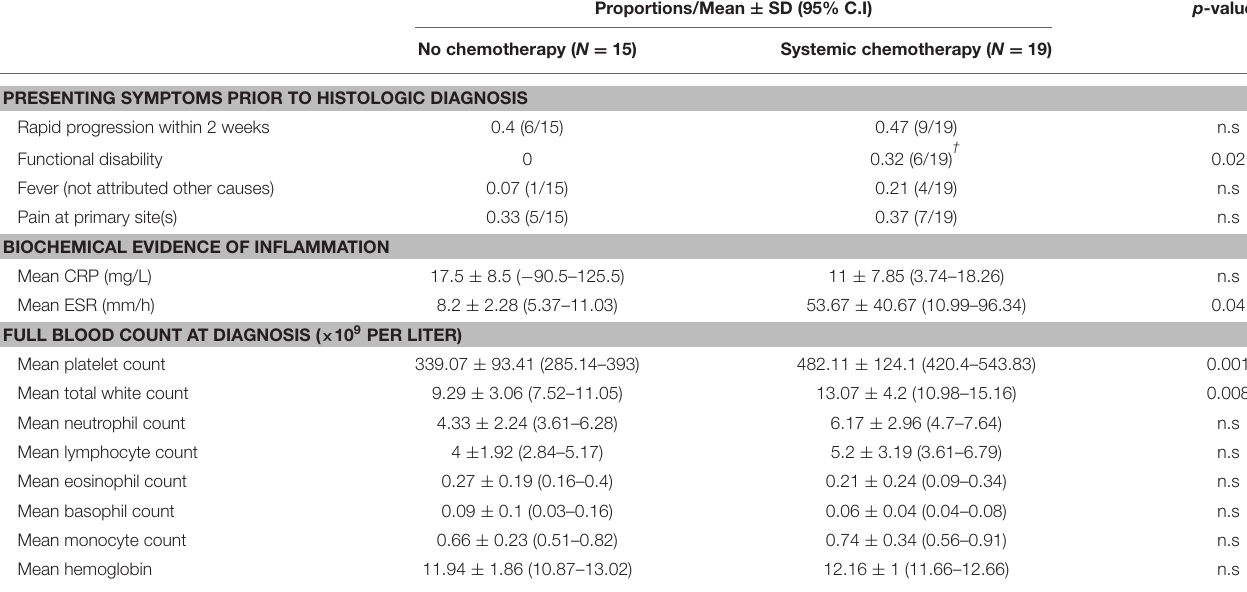
TABLE 3 | Analysis of indicators of disease